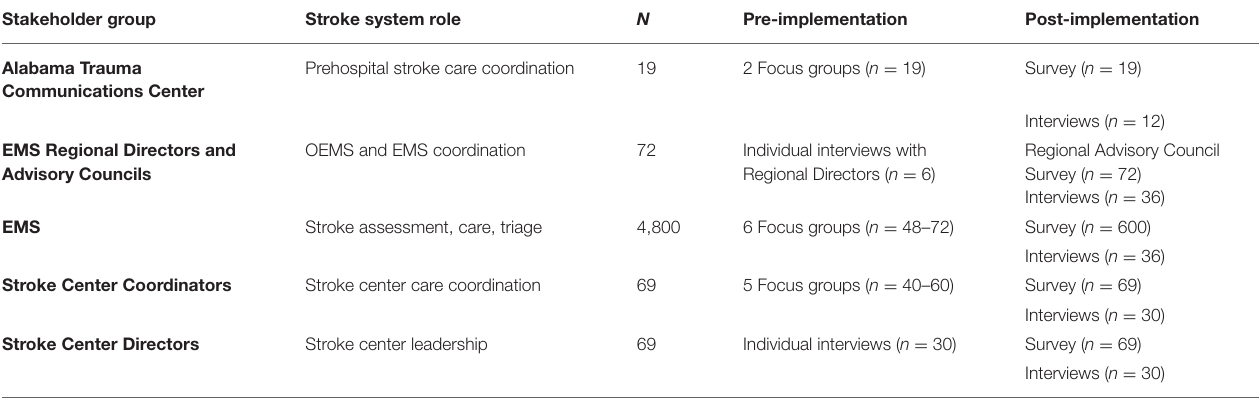
TABLE 4 | Mixed methods data collection by stakeholder